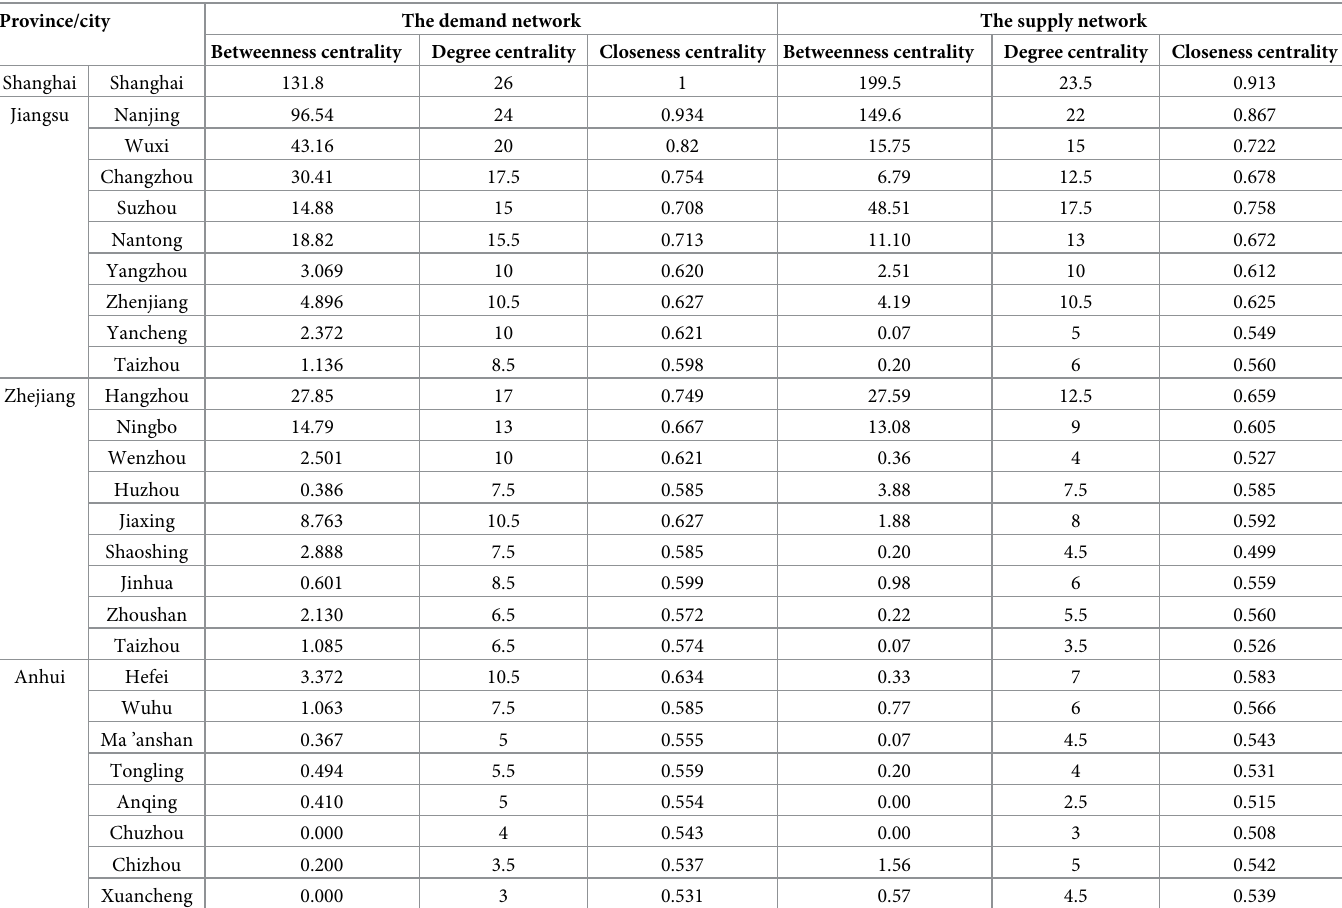
Table 3. Centrality index of nodes in the demand network and the supply network.